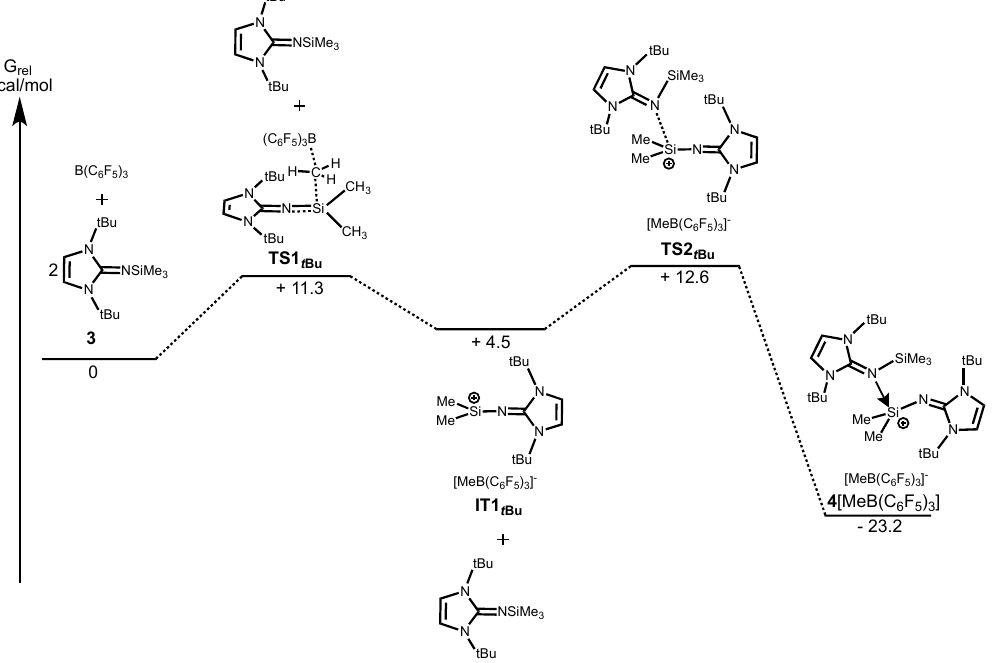
Figure 4. Reaction profile for the reaction of 3 with B(C 6 F 5 ) 3 .